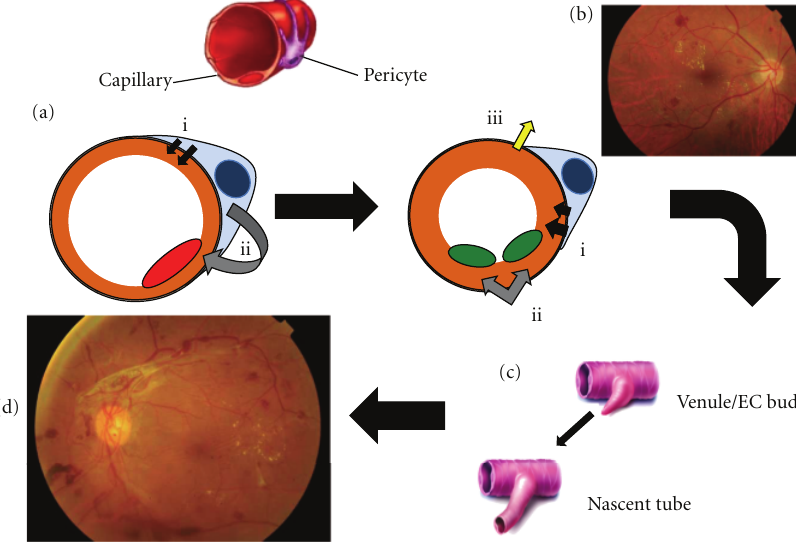
Figure 1: Schematic representation of the progression of diabetic retinopathy. Pericytes interact directly with the normal retinal capillary endothelium (a) within the basement membrane via close contacts and gap junctions ensuring basal tone a(i) and growth arrest a(ii). Persistent hyperglycemia leads to RhoGTPase induction of pericyte contraction b(i) causing reversal of EC growth arrest b(ii) and disrupted matrix contact b(iii) prior to or in the absence of pericyte death/dropout. Basement membrane thickening and leaky, narrow capillaries contribute to thrombosis, ischemia, and the first detectible abnormalities of NPDR. In response to the resultant hypoxia, soluble mediators of angiogenesis, such as VEGF, are released to develop collateral nutrient supply by forming nascent capillary tubes (c). These new blood vessels are highly permeable and fragile and disrupt easily causing hemorrhage and the vision loss characteristic of PDR